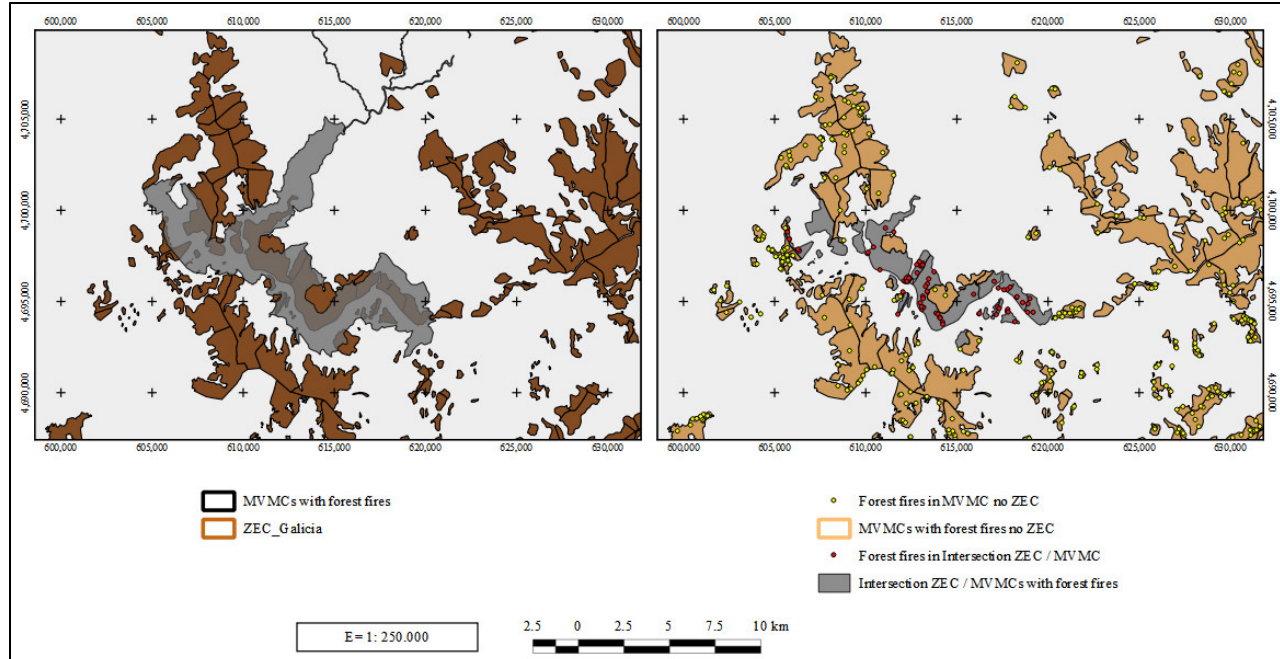
Figure 6. Cartography of intersections. Occurrence of forest fires in MVMC ꓵ SAC intersection zones and in MVMCs outside SACs. By intersecting the SAC (grey colour), forest fires (yellow colour) and MVMC (brown colour) layers, we obtained the territorial units in which the different occurrences of forest fires were subsequently analysed. The ochre colour shows the areas included in the territorial unit MVMC no SAC. The coordinate reference system used in the production of the maps was ETRS89/UTM Zone 29N.